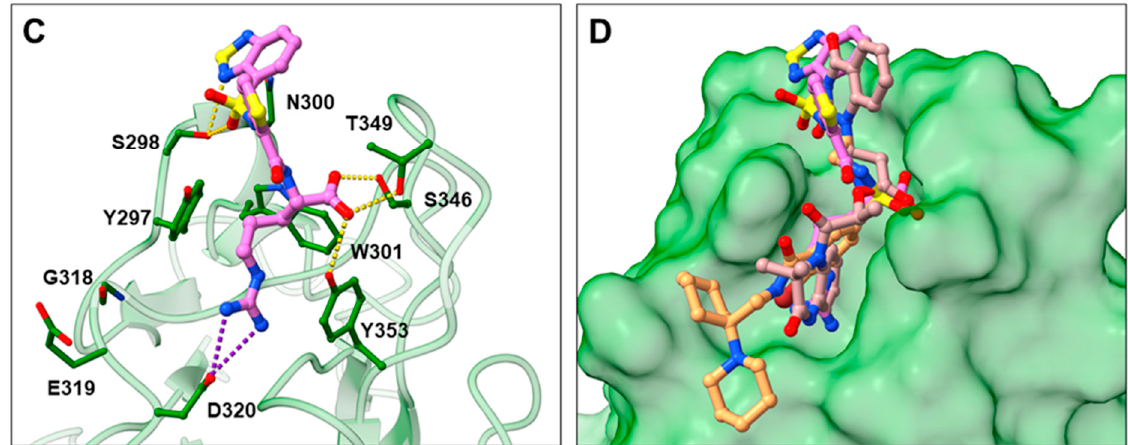
Figure 4. Predicted binding poses of compounds 16 ( A ) and 17 ( B ) as well as the binding mode of compound 21 (( C ); PDB ID 3i97) [35] within the SARS ‐ CoV ‐ 2 CendR binding pocket on the b1 NRP1 domain (PDB ID: 6FMC) [38]. NRP1 is depicted in green cartoon representation, while ligands and key amino acids are in stick representation. Hydrogen, salt bridge and π‐π stacking interactions are depicted as yellow, violet, and cyan dashes, respectively. Overlay of the predicted binding modes of compounds 16 and 17 with the binding pose of compound 21 ( D